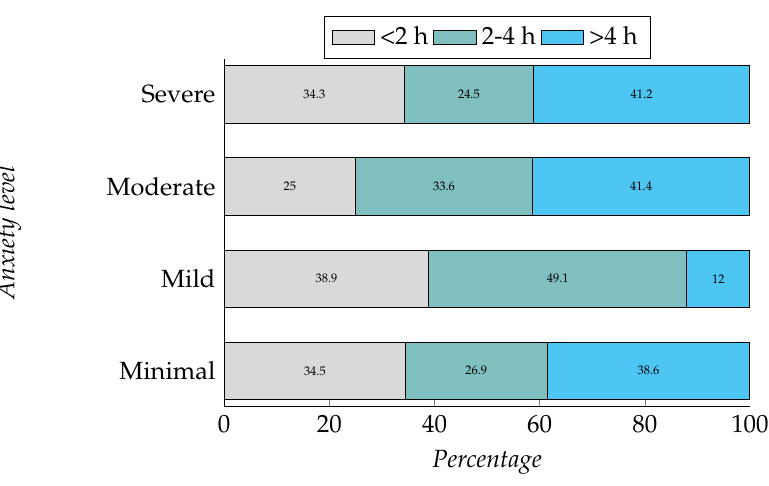
Figure 4. Relation between time spent on personal care and their level of